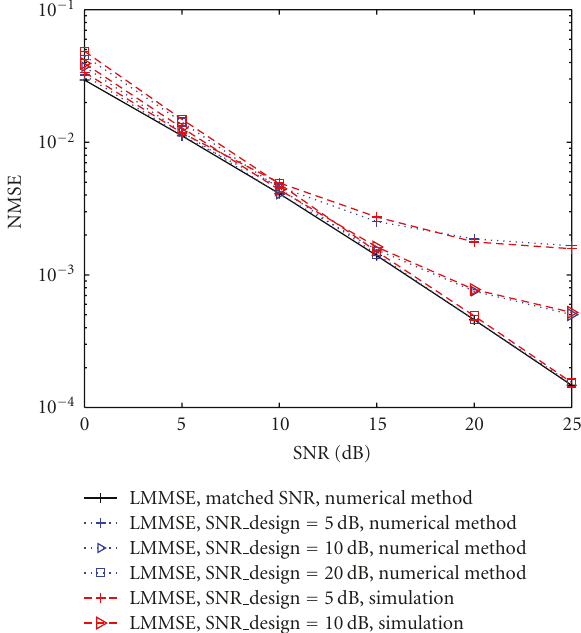
Figure 6: NMSE of LMMSE algorithm with matched SNR and mismatched SNRs versus SNR, by simulation and numerical method,